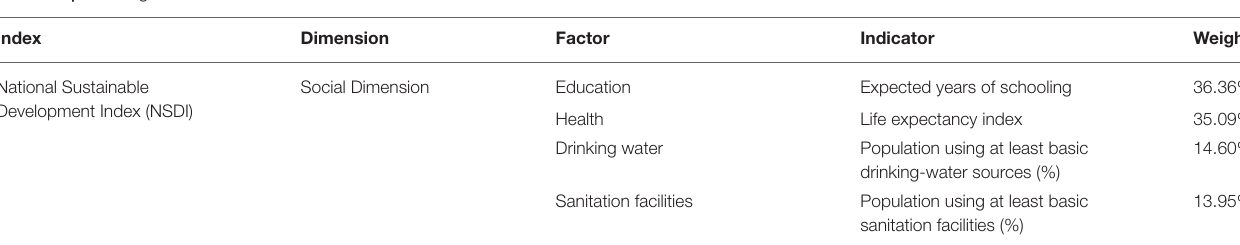
TABLE 3 | The weights of the four